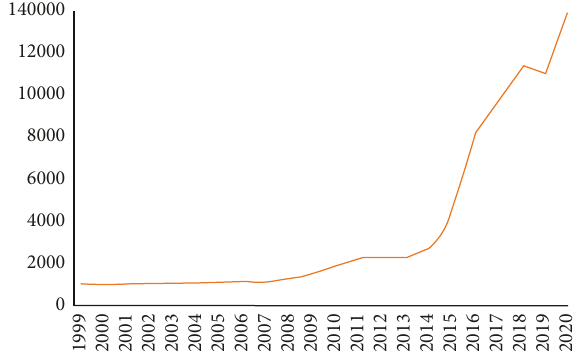
Figure 1: The overall trend of innovation and entrepreneurship education